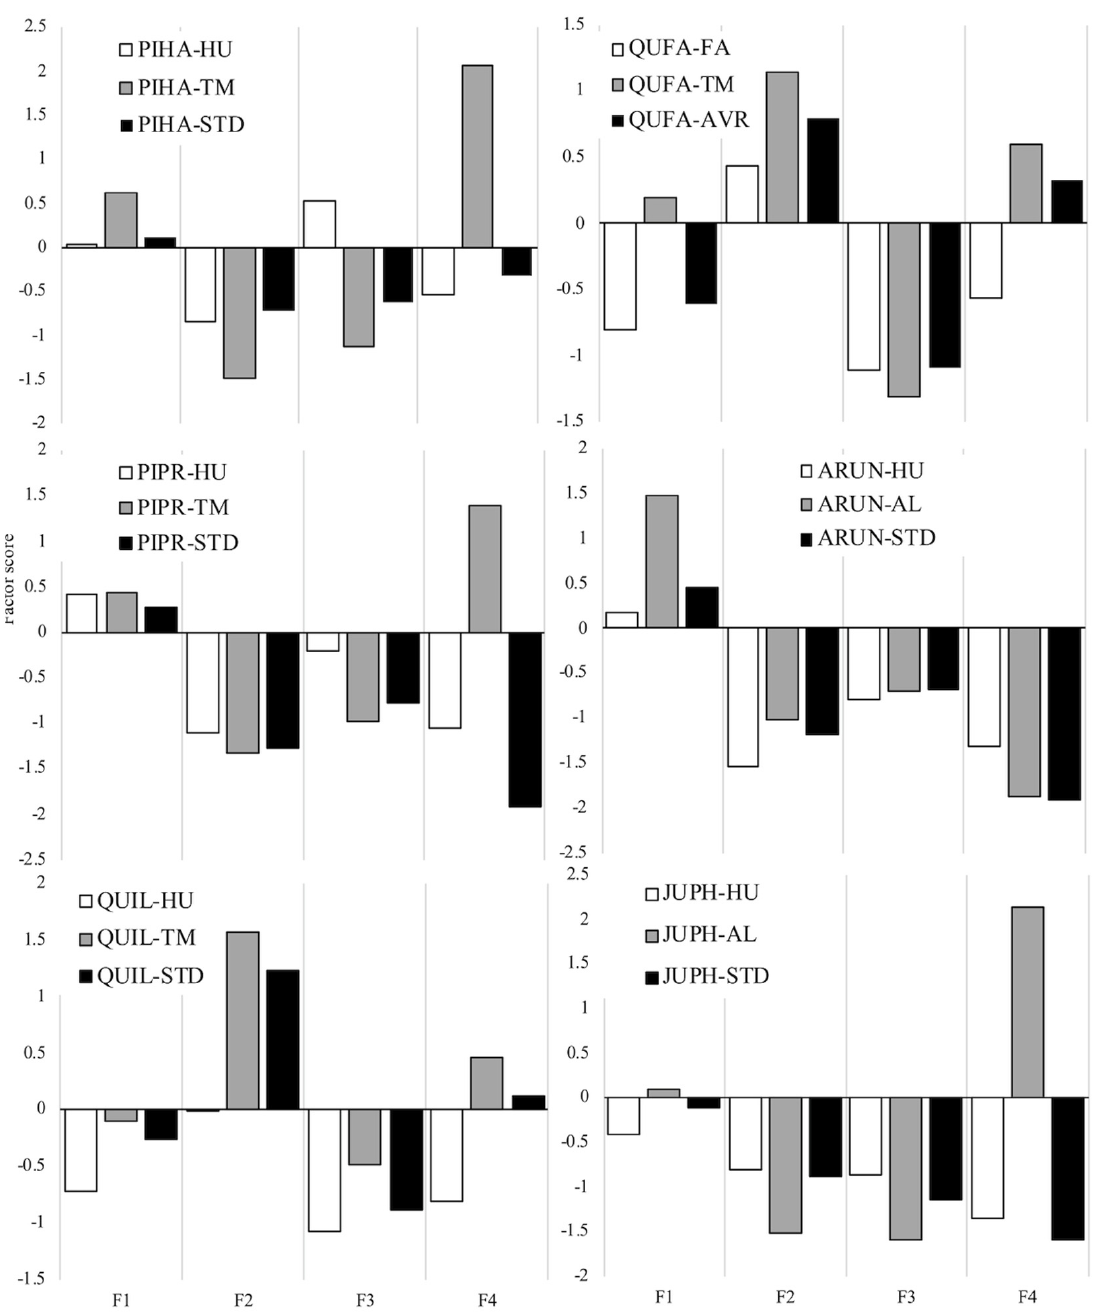
Figure 2. Values of the four components (F1, F2, F3, F4) extracted from the factor analysis for the two stocklots in each species used in this study and that of the species’ standard (STD) for the Valencia region. In the case of Lusitanian oak (QUFA), the average is used as the reference (AVR). See Table 1 for abbreviations of the species and stocklots. The correlations between the initial variables and the components are shown in Supplementary Table S3.